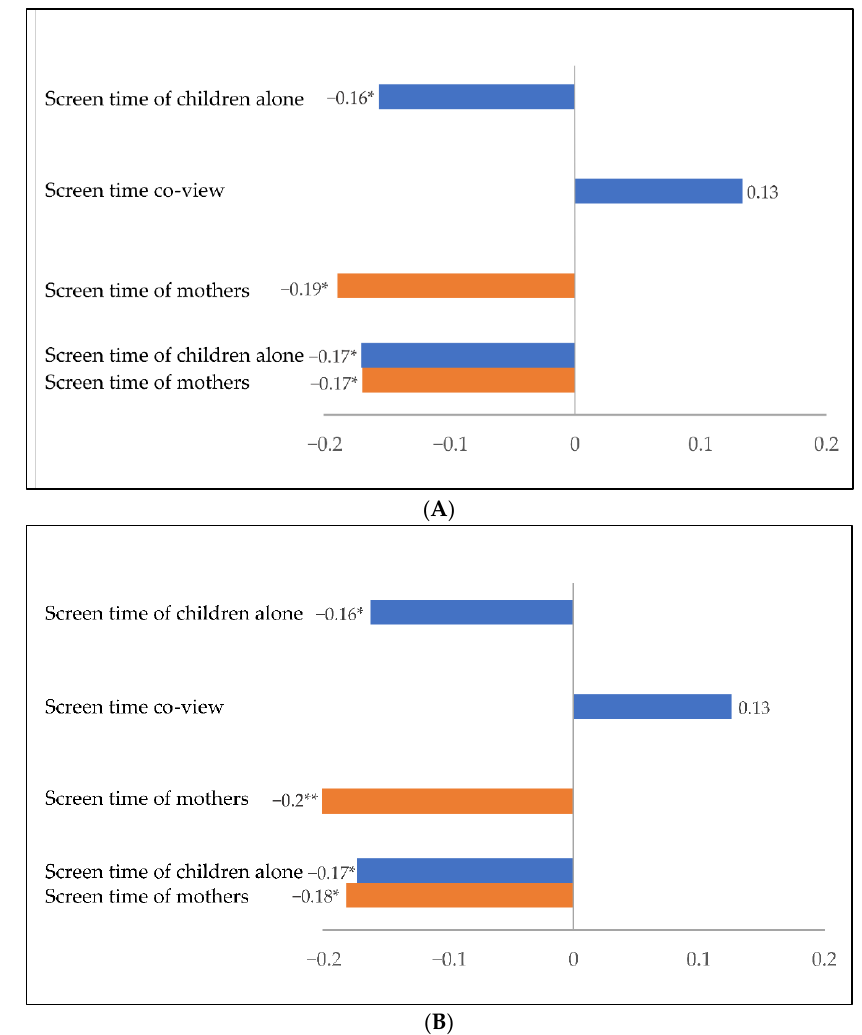
Figure 1. Standardized Beta-values of the screen time variables from the regression models for the dependent variables FinCDI III Words (score of vocabulary section of Finnish version of MacArthur Communicative Development Inventories III; ( A ) and FinCDI III Total score ( B ). A negative value indicates a negative association between the screen time variable and the language skill. The blue bars represent children’s screen time, and the orange bars represent mothers’ screen time. The last two Beta-values at the bottom of the charts represent the results from the combined models (including both the screen time of children alone and the screen time of mothers). Children’s age, maternal education level, and birth order were controlled for in all models. * p < 0.05; ** p < 0.01.